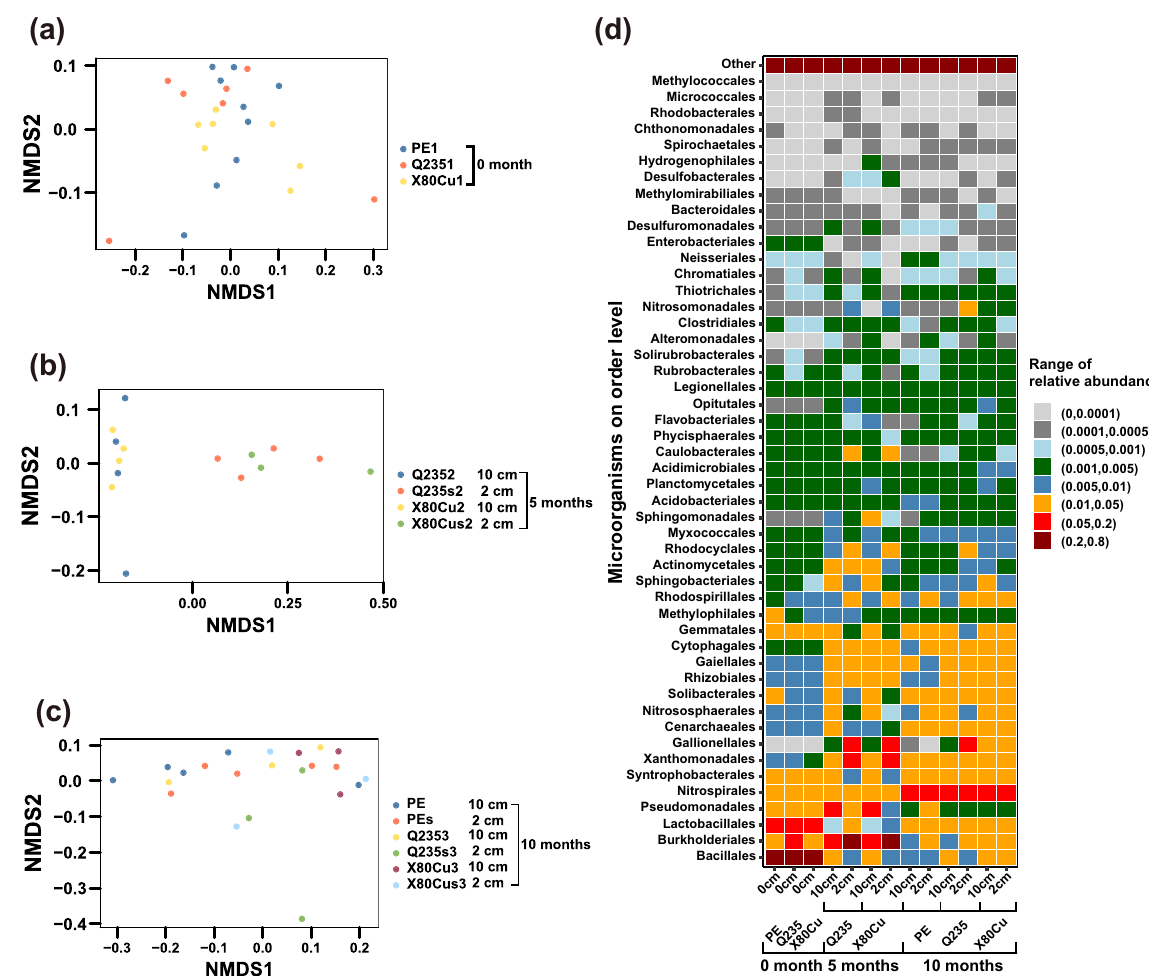
Fig. 4 Differences in community composition of different materials. Non-metric multidimensional scaling (NMDS) analysis based on Bray – Curtis distance matrix among sample groups at different sampling time ( a – c ) and relative abundance of microbial orders detected in different soils ( d